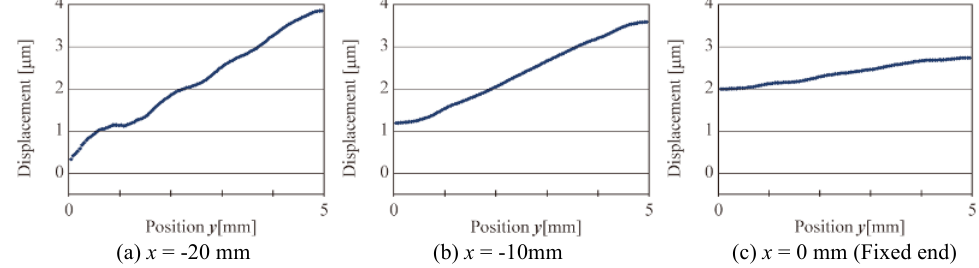
Fig. 12. Section of displacement distribution for the x -direction